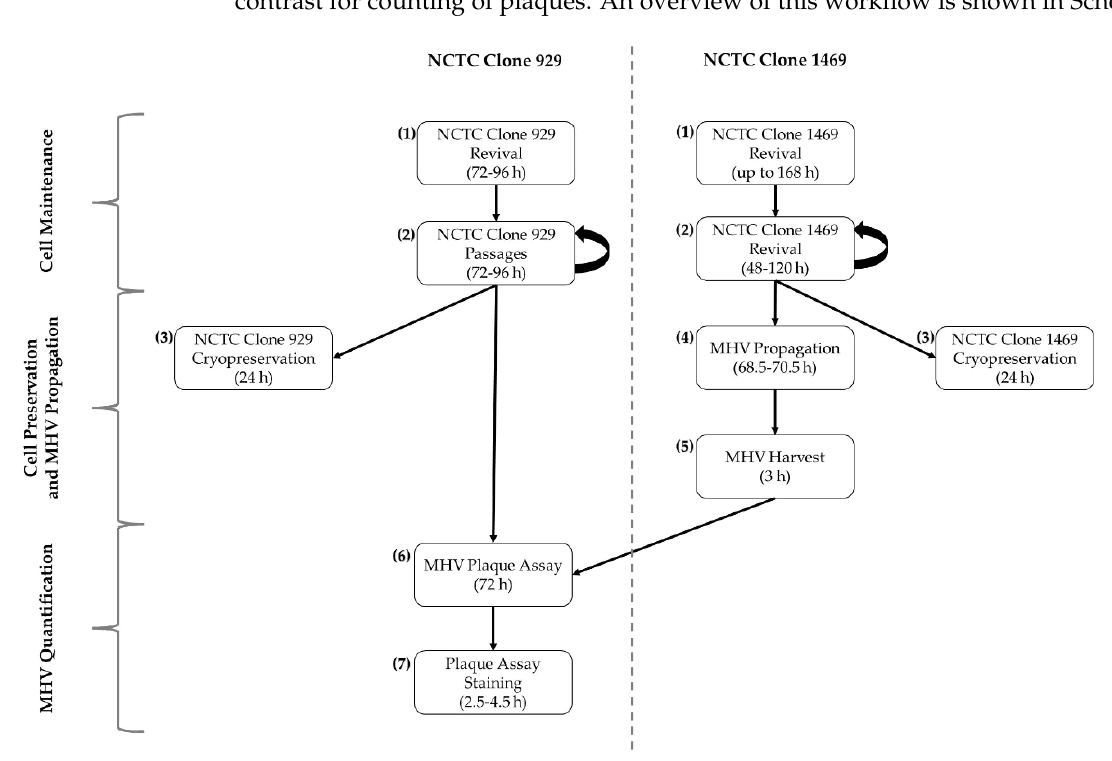
and quantification. The time required for each step is listed in parenthesis. The workflow begins with cell maintenance including (1) revival of frozen cells. Afterwards, (2) the cell lines are